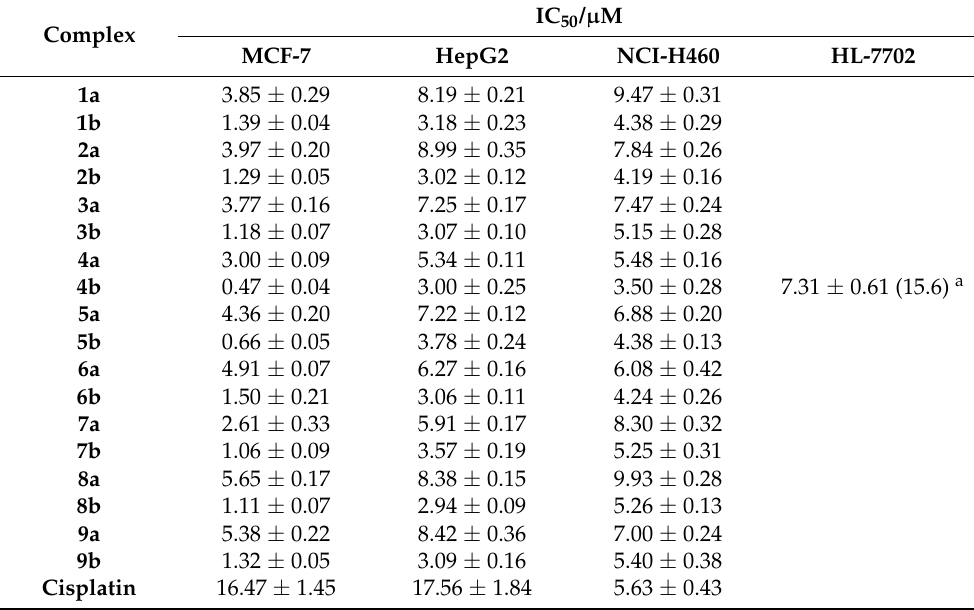
Table 1. Inhibition action of the complexes to cancer cells in